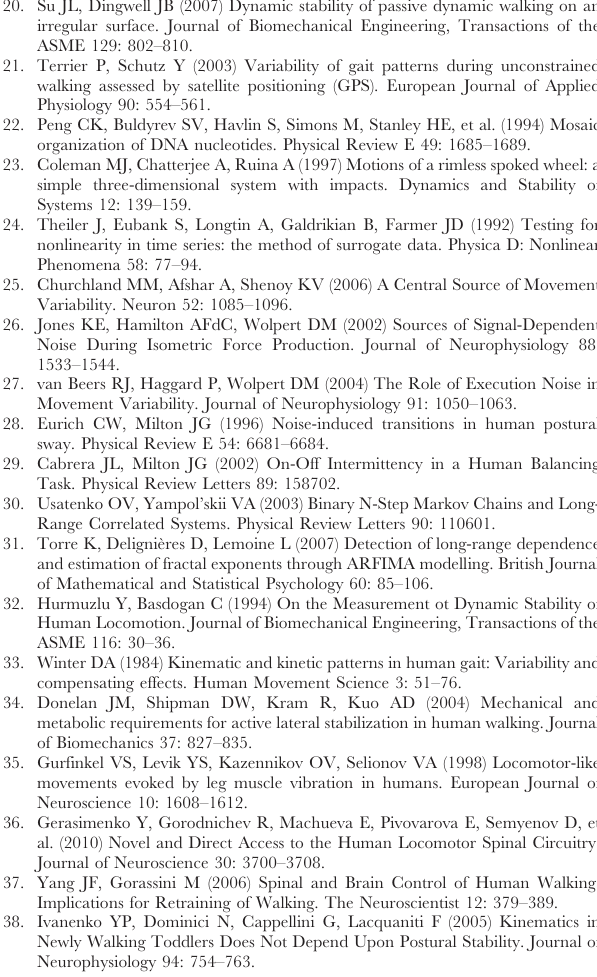
Figure S1 A graphical illustration of monotonic conver- gence to the fixed point. The intersection of y = x and y = g ( x ) corresponds to the period-one gait or the fixed point, x fixed . Any initial condition of x should converge to x fixed monotonically following the green arrows. This precludes the model from exhibiting period- n ( n $ 2) gaits or